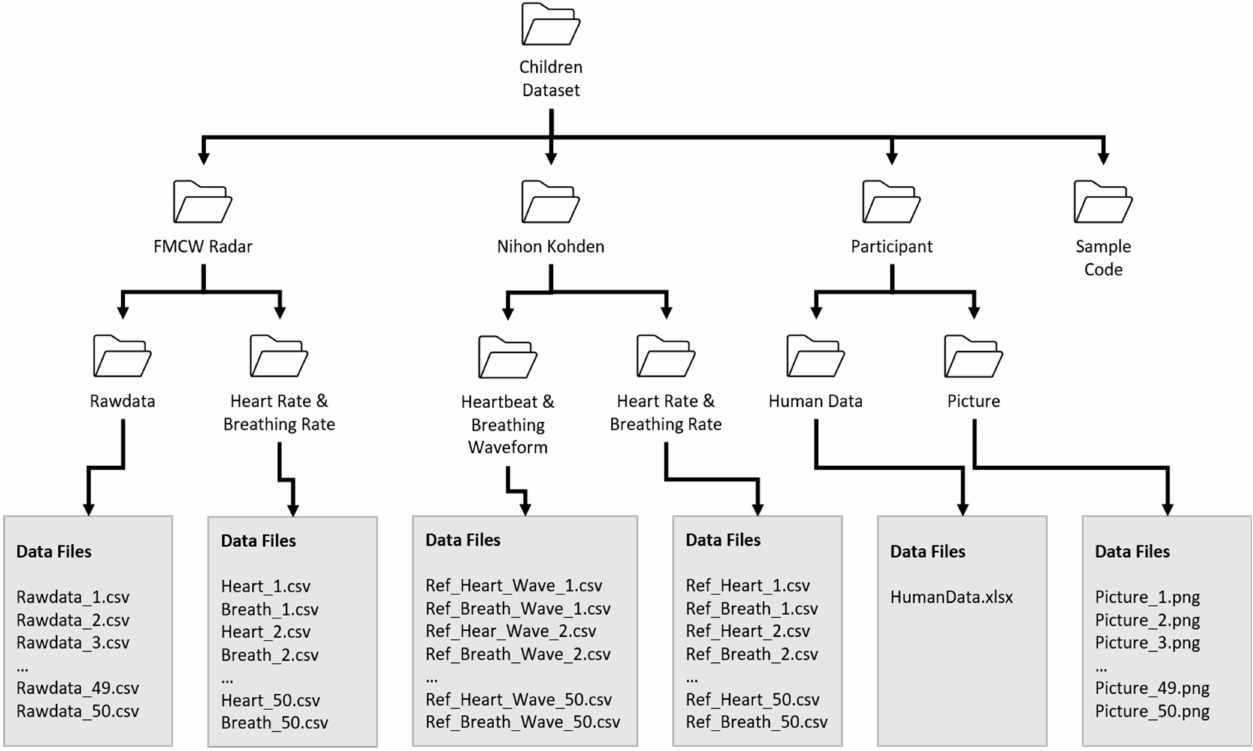
Figure 5. The structure of the proposed child vital sign